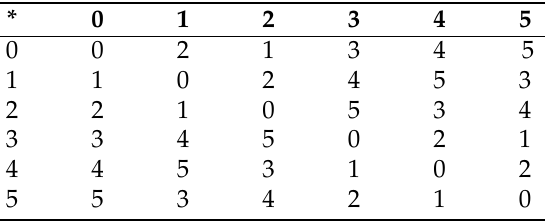
Table 2. Cayley table for the binary operation “ ∗